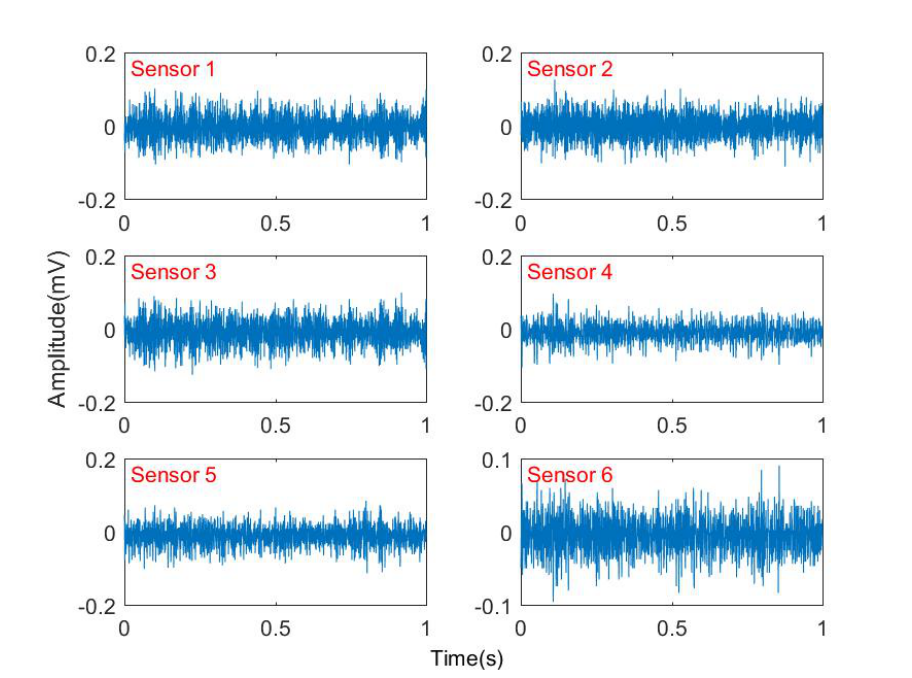
Figure 6. Waves of vibration signals under inner-race